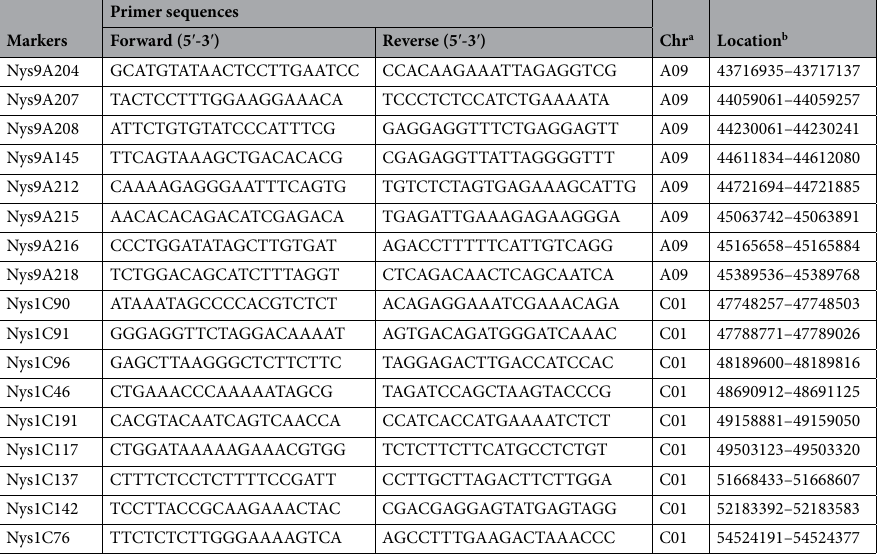
Table 2. Polymorphic markers used for linkage analysis. a Chr is the chromosome. b Location is the marker position on the reference genome sequence.